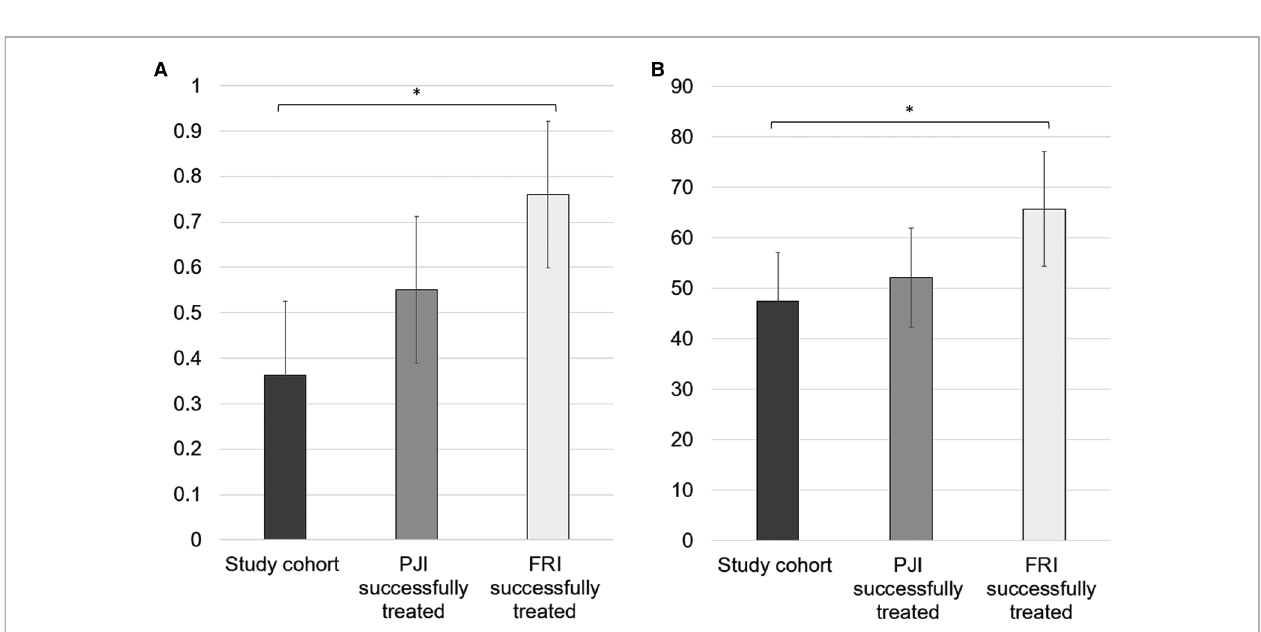
FIGURE 4 | ( A ) Mean EQ-5D index value on a scale 0 – 1 and ( B ) mean EQ-5D VAS (visual analogue scale) rating on a scale 0 – 100. For a comparison, the values of the successfully treated PJI and FRI population are illustrated in gray and light gray, respectively. * illustrates statistical signi fi cance on a p <0.05 level determined by an independent t